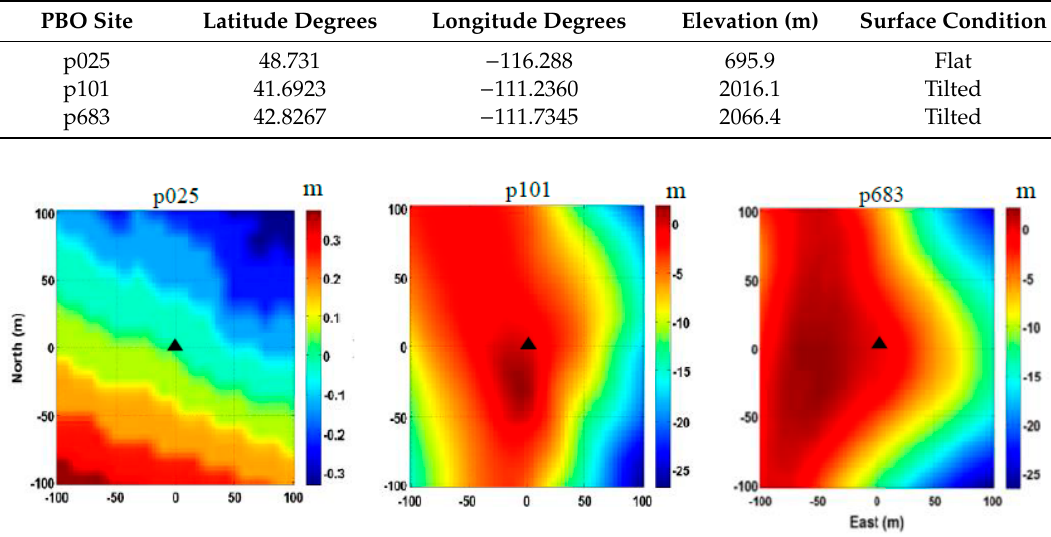
Figure 2. Digital elevation models (DEMs) for the selected GPS sites of p025, p101, and p683, black triangles denoting the location of GPS sites (the value at the center of DEM diagram is 0 m [27]).